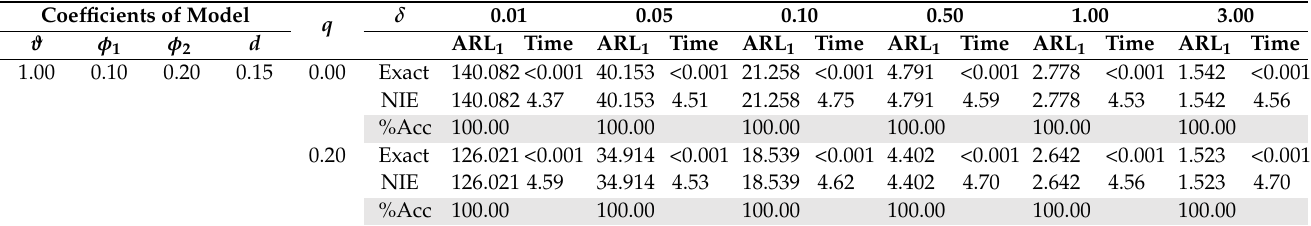
Table 5. The ARL 1 results using the exact formula and the numerical IE technique for ARFI(2, d ) processes running on the modified EWMA control chart with λ =